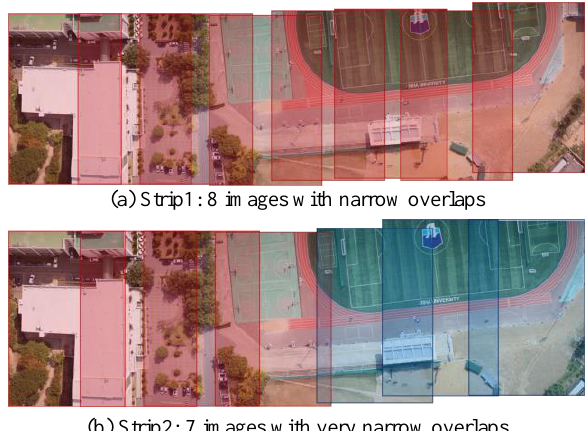
Figure 3. Two strips of UAV images with narrow